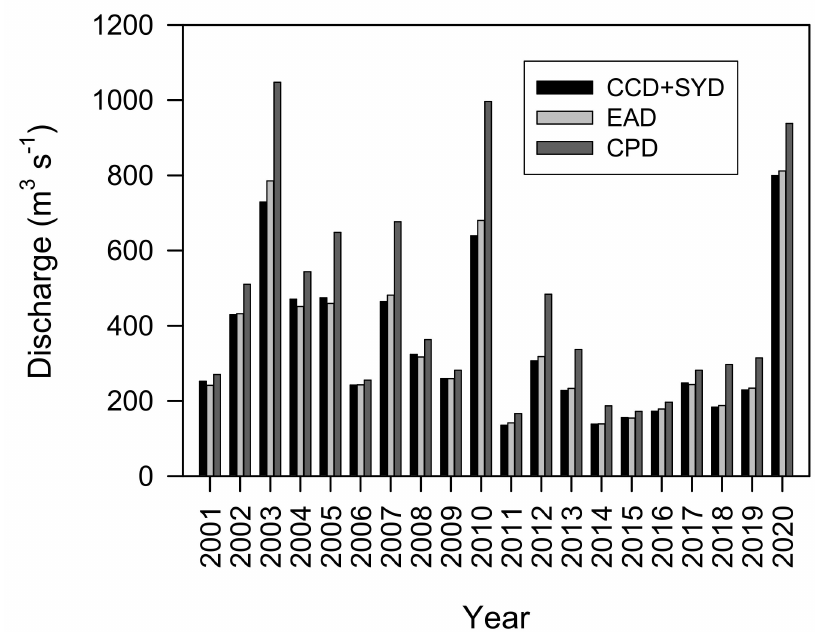
Figure 8. Spatial distribution of the total outflow discharged from the dams of the Chuncheon (CCD), Soyang (SYD), Euiam (EAD), and Cheongpyeong (CPD) Reservoirs between September and November every year for the past 20